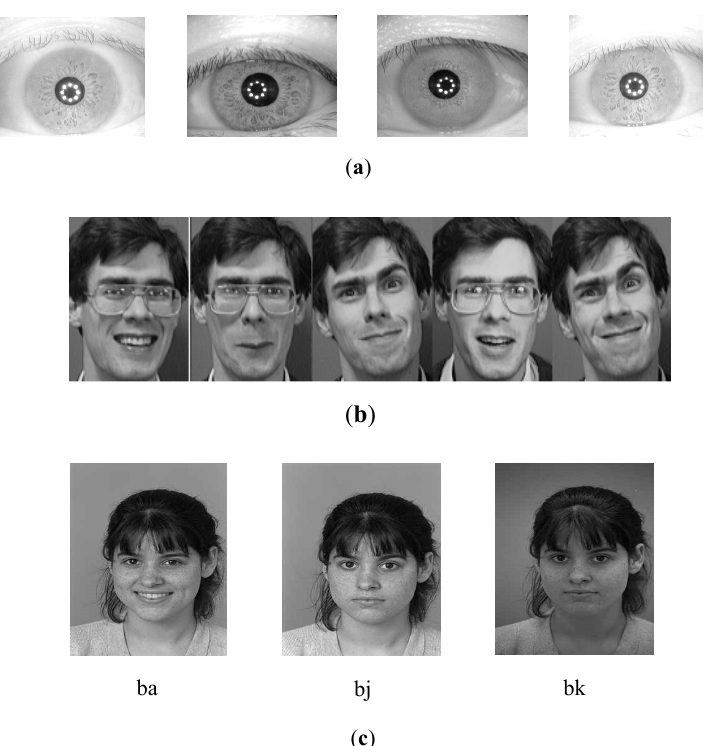
Figure 7. Examples of face and iris images from ( a ) Chinese academy of science institute of automation (CASIA), ( b ) Olivetti research laboratory (ORL), and ( c ) Face recognition technology (FERET).